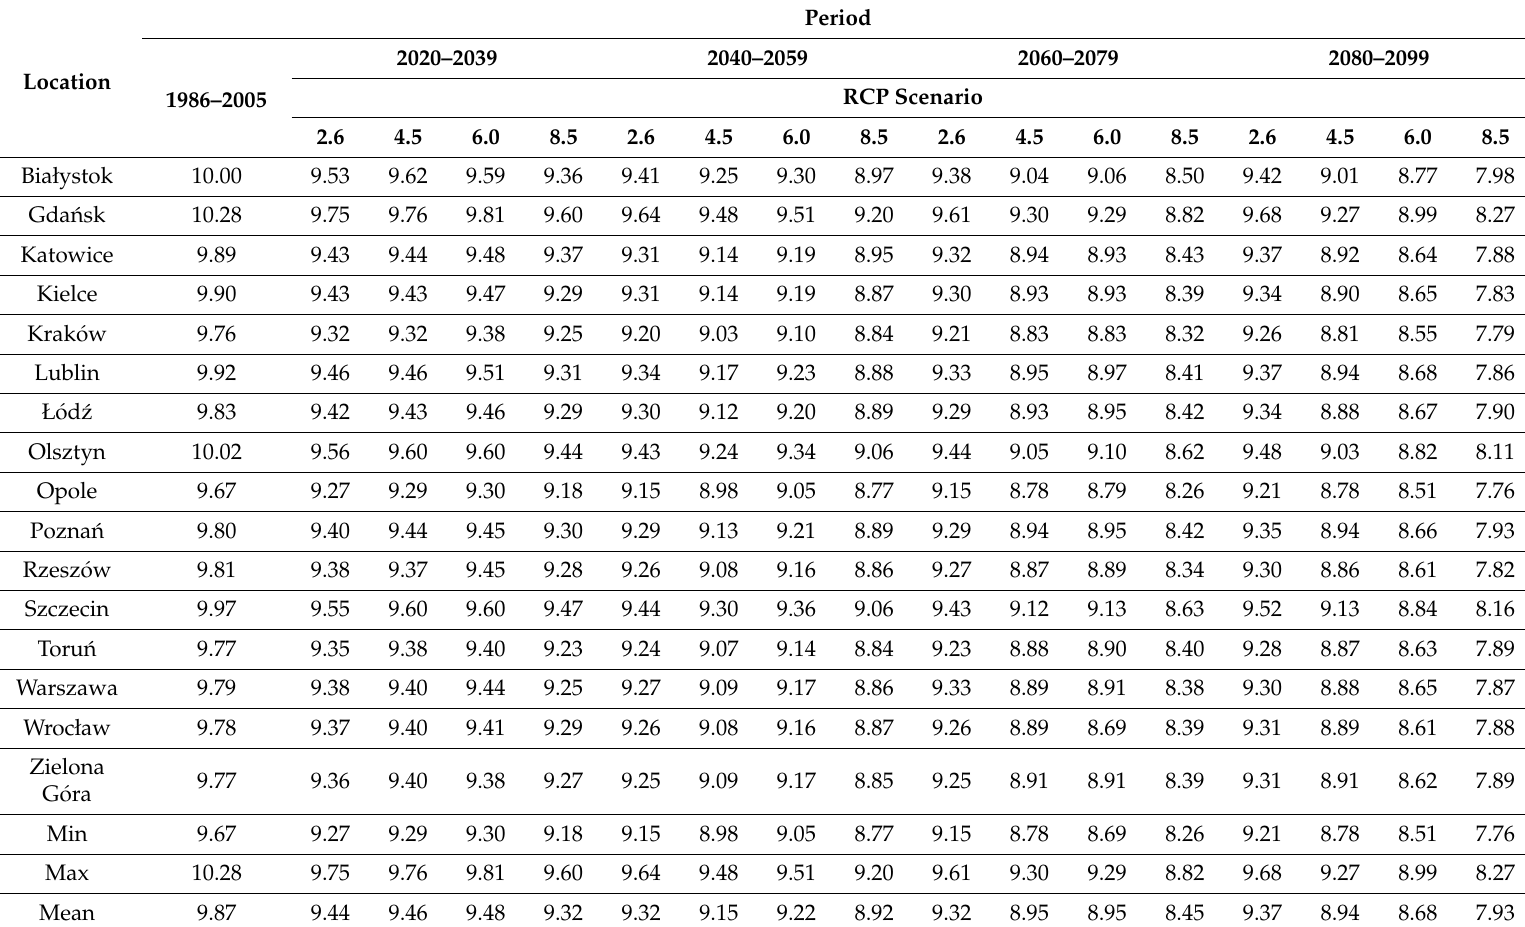
Table 13. Linolenic acid content in oilseed rape seeds calculated for the period of 1986–2005 and predicted for four RCP scenarios (2.6, 4.5, 6.0, 8.5) and four periods